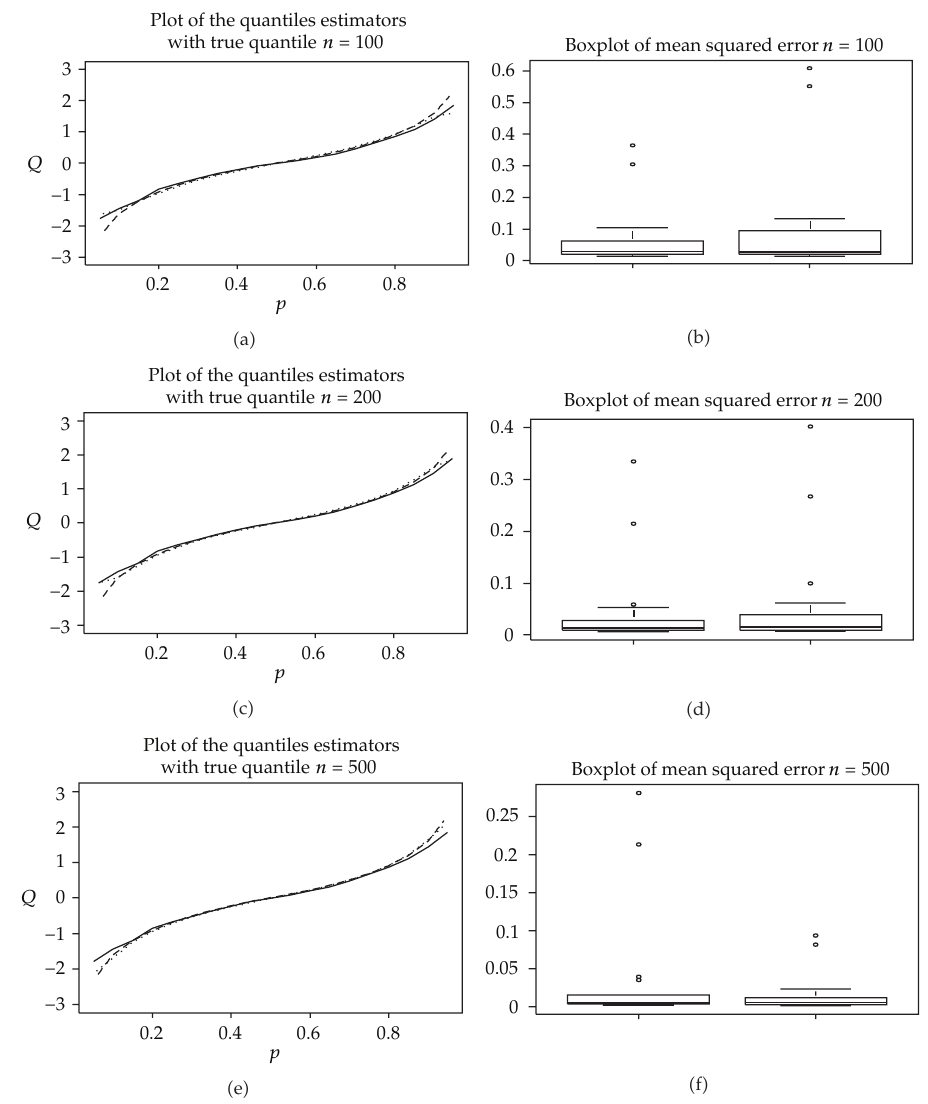
Figure 4: Left panel: plots of the quantile estimators for method 1 (cid:4) solid line (cid:5) , method 2 (cid:4) dotted line (cid:5) and true quantile (cid:4) dashed line (cid:5) for di ff erent sample sizes and for data from a double exponential distribution. Right panel: box plots of mean squared error for the quantile estimators for method 1 and method 2 for di ff erent sample